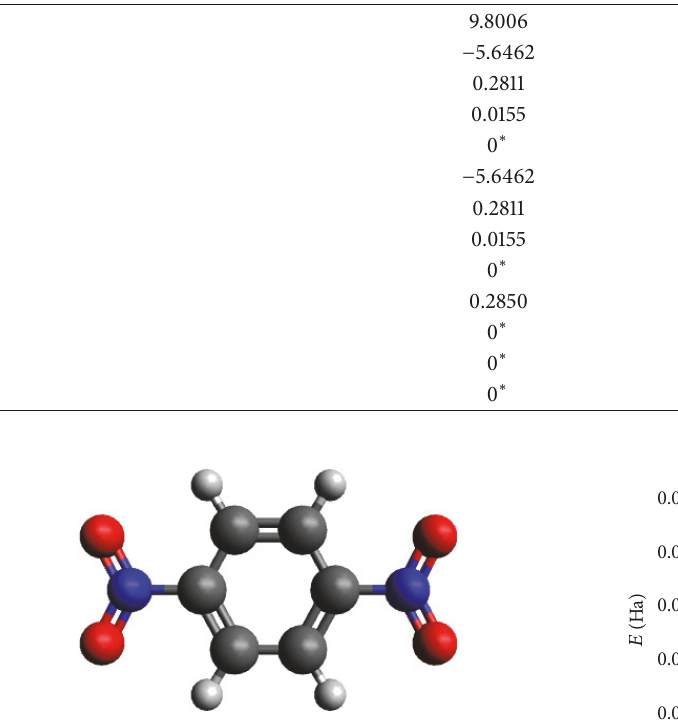
Figure 2: The ground state conformation of paradinitrobenzene.